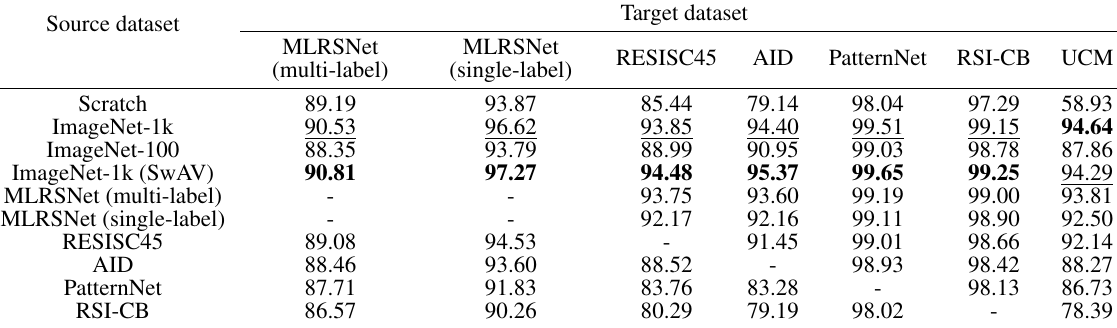
Table 5. Classification accuracies/F1-measures (%) on 20% of the images from the target datasets obtained by fine-tuning the pre-trained networks. The best result for each target dataset is given in bold, and the second best is underlined. A notable exception is UCM with too few training images for training a classifier from scratch. This result is in line with (Pires de Lima and Marfurt, 2020).